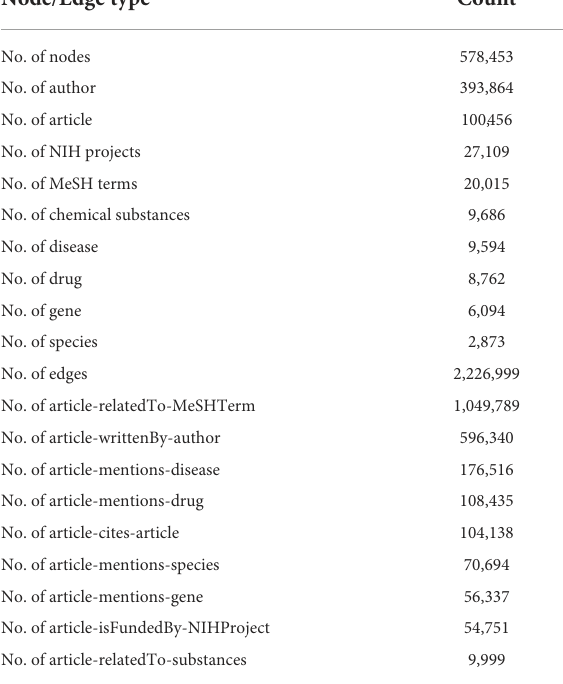
TABLE 2 The description of node and edge types in the extracted knowledge